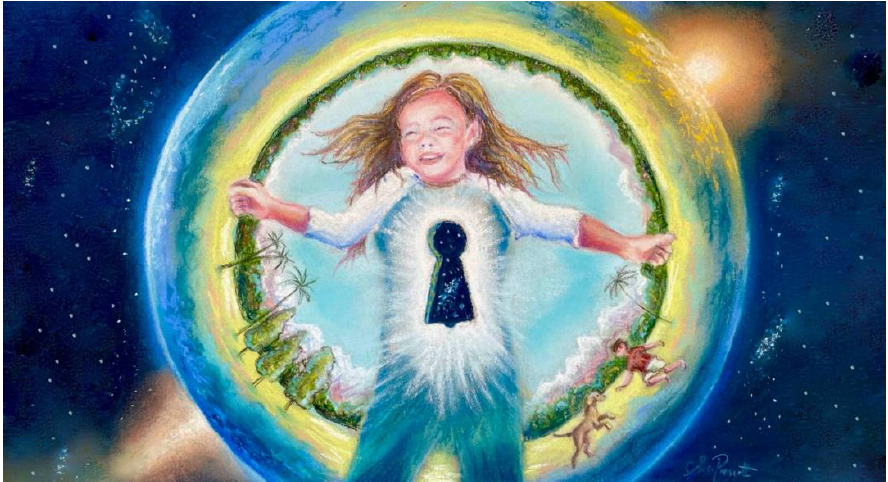
Figure 4. “From the inside out”— internal transitions promote external transformation: Mindfulness and contemplative practices can build personal resilience and strengthen conscious connections for pro-social and pro-environmental attitudes —with growing evidence linking ‘internal’ transformation to ‘external’ actions for sustainability. (Art created by author S.L.P.).